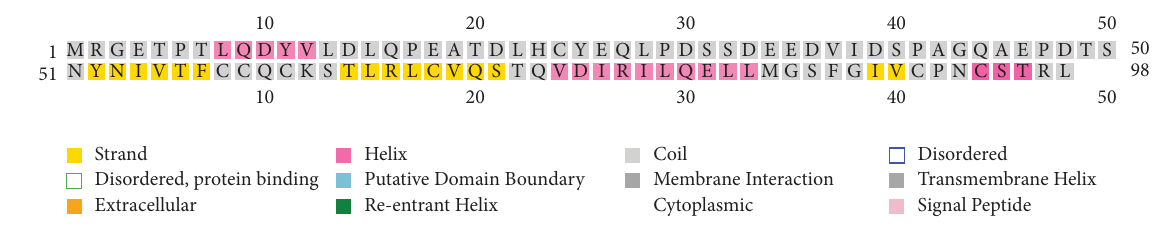
Figure 2: Te secondary structure of HPV31 E7